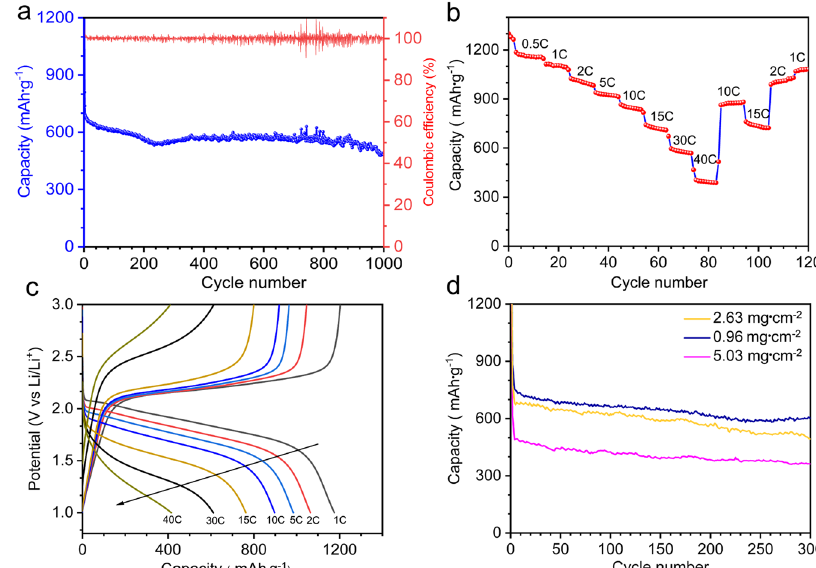
Fig. 5 Rate performance and high loading analysis of γ S-CNFs. a Long cycling of γ S-CNFs at a low current rate 0.1 C at 1.2 mg·cm − 2 loading. b Rate performance of γ S-CNFs in carbonate electrolyte at 0.5 mg·cm − 2 . c Charge – discharge pro fi les of γ S-CNFs at various C rates. d Long cycling as a function of higher loading. The cells were assembled with variable S loading of 1.2 – 5.03 mg·cm − 2 using ~50 wt% sulfur and an E/S ratio of